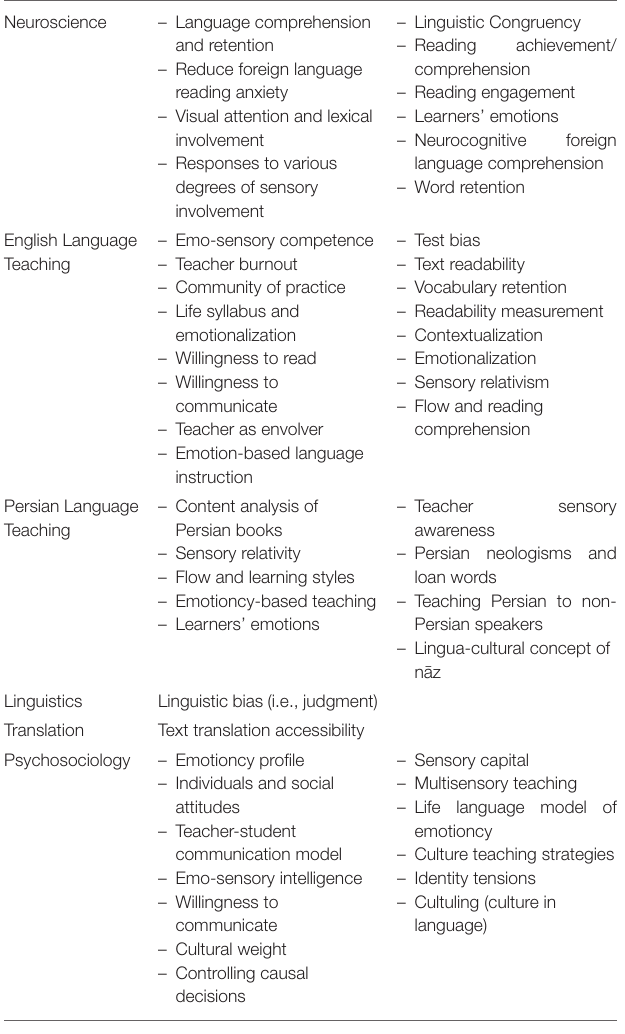
TABLE 2 | Themes explored in emotioncy